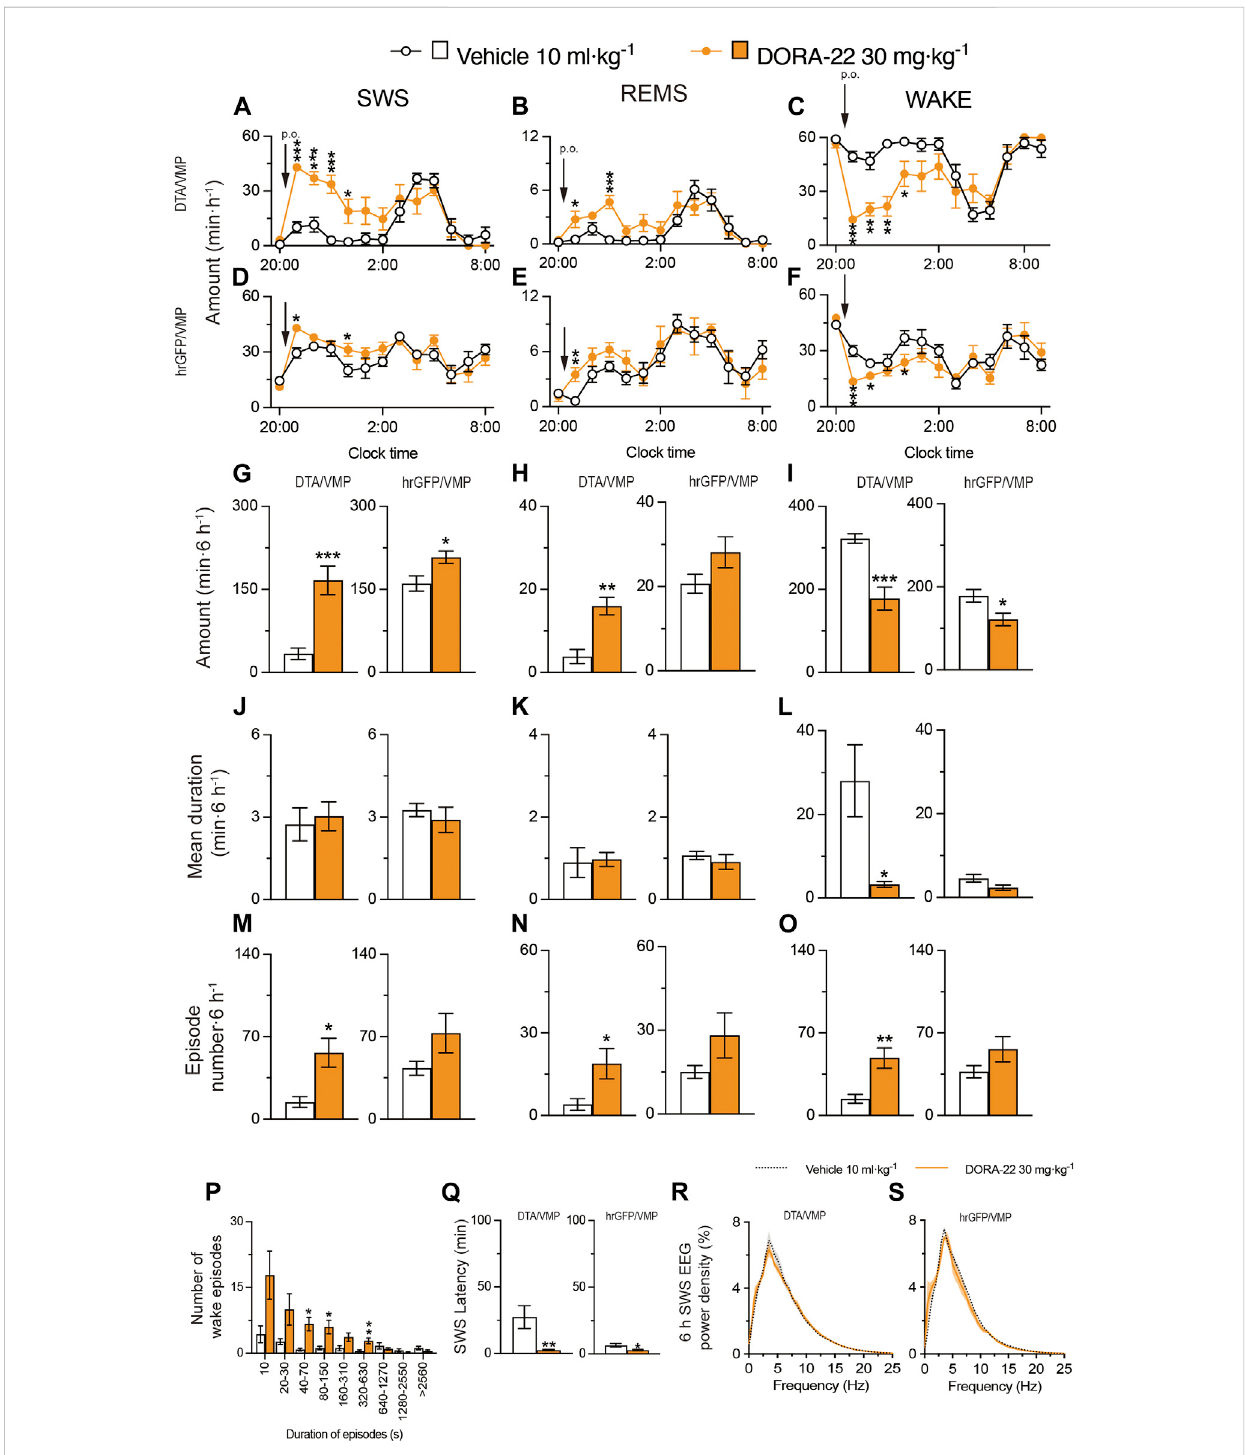
FIGURE 4 OraladministrationofDORA-22inducessleepinmicewithmania-likebehavior. (A – O) Timecourse (A – F) ,totalamount (G – I) ,meanduration (J – L) , and episode number (M – O) of SWS, REMS,and wakefulness in VGAT-Cre DTA/VMP and VGAT-Cre hrGFP/VMP mice after administering vehicle or DORA-22. (P) Wake episode spectrum in VGAT-Cre DTA/VMP mice. (Q) Latency to sleep onset in VGAT-Cre DTA/VMP and VGAT-Cre hrGFP/VMP mice after administering vehicle or DORA-22. (R,S) SWS EEG power density for 6 h after injection of vehicle or DORA-22 into VGAT-Cre DTA/VMP (R) and VGAT-Cre hrGFP/VMP (S) mice. Data (n = 6/group) are presented as mean ± SEM. Signi fi cance levels are indicated as * p < 0.05, ** p < 0.01, and *** p <